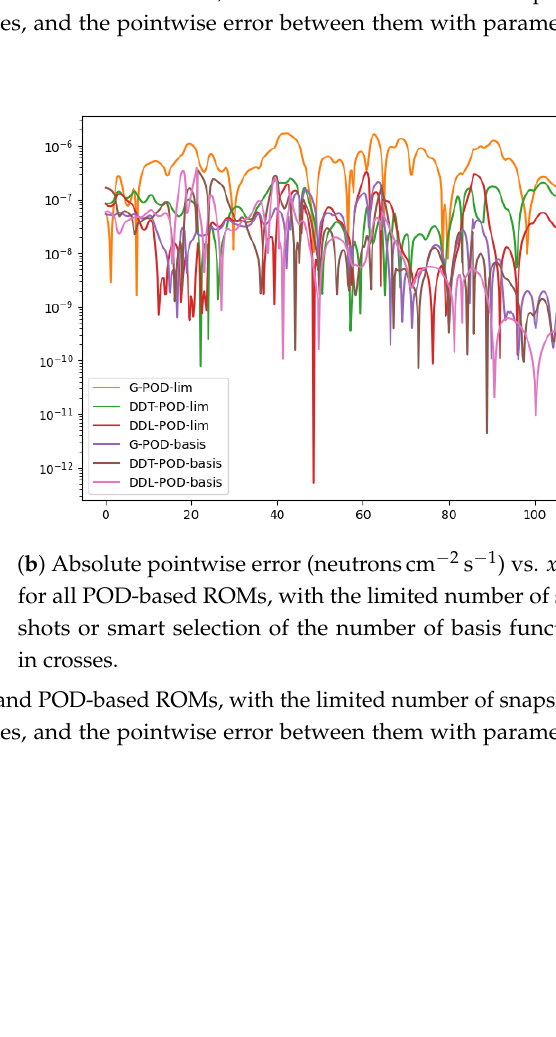
for all POD-based ROMs, with the limited number of snap- shots or smart selection of the number of basis functions, in crosses.